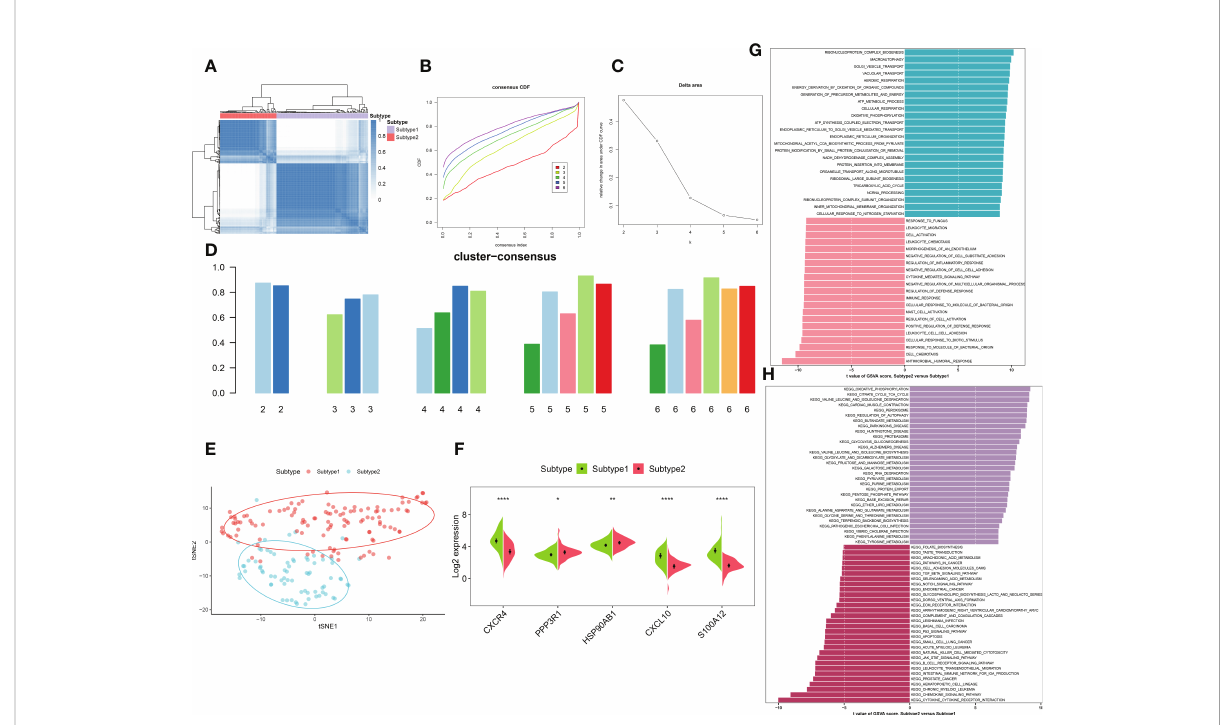
FIGURE 9 Identi fi cation and enrichment analysis of immune microenvironment subtypes. (A) Consensus clustering matrix when k = 2. (B) Consensus CDF curves when k=2 to 6. (C) Relative alterations in CDF delta area curves. (D) Consensus score of each subtype when k=2 to 6. (E) t-SNE diagram separated subtype1 (pink) and sybtype2 samples (blue). (F) Split violin plots revealing the expression of 5 characteristic genes between subtypes. (G, H) Differences in enriched biological functions (G) and hallmark pathways (H) between distinct immune microenvironment subtypes ranked by t values of GSVA scores. *p < 0.05, **p < 0.01, ****p <